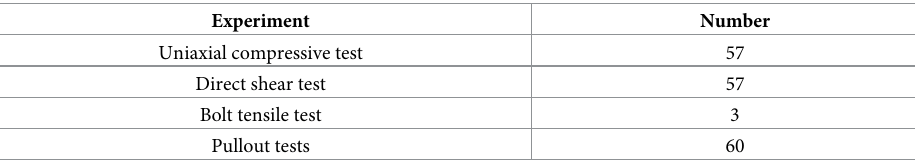
Table 1. Experiment and testing